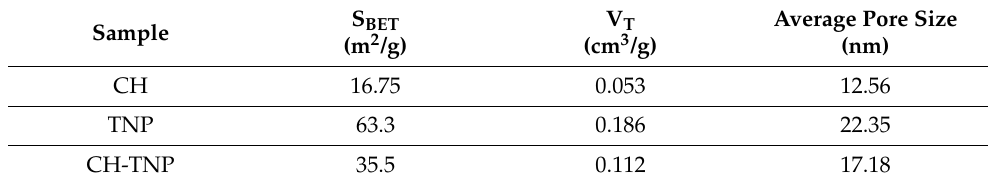
Table 1. Summary of surface analysis data.